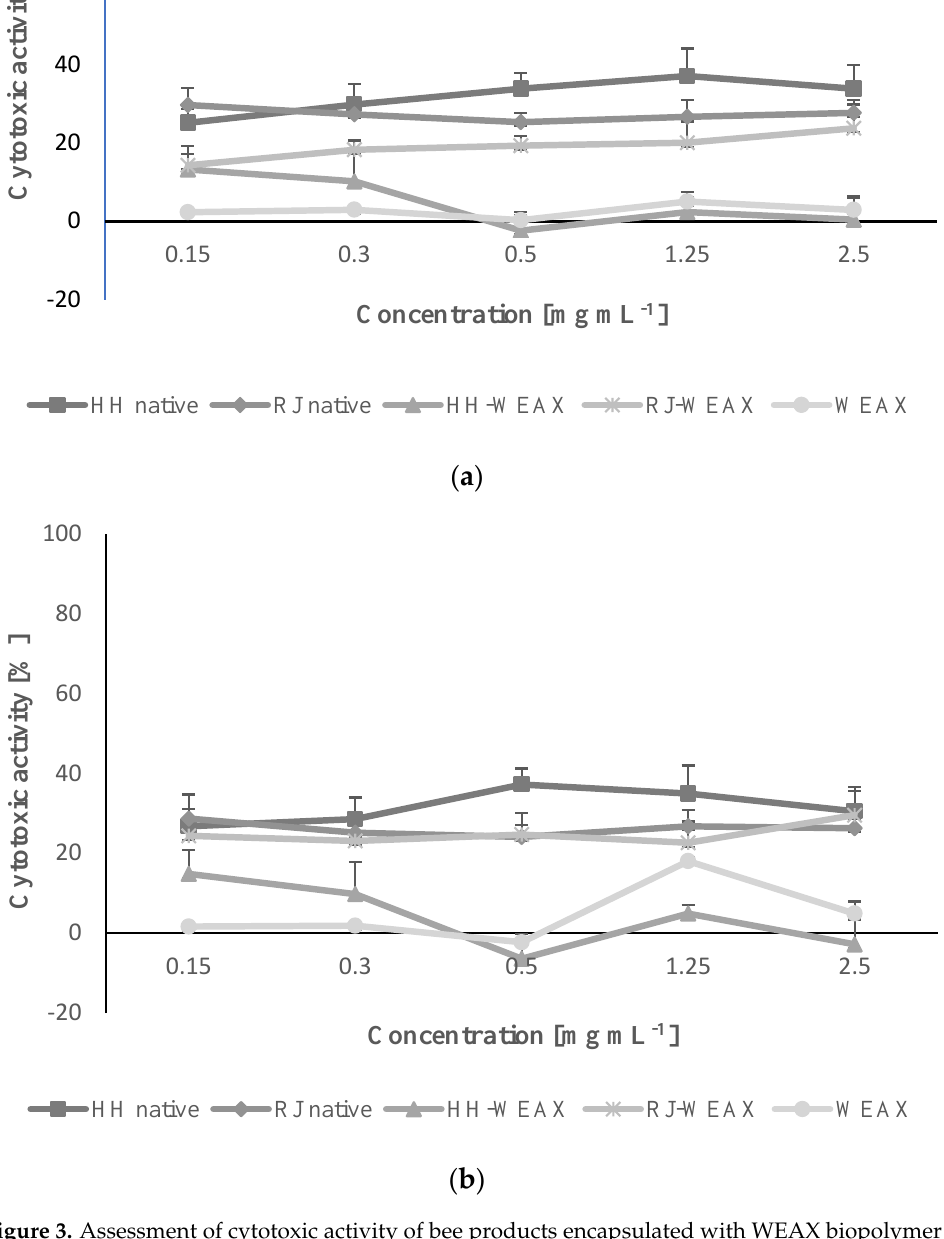
Figure 3. Assessment of cytotoxic activity of bee products encapsulated with WEAX biopolymer at 0.15 mg mL — 1 concentration against NIH-3T3 ( a ) and HMEC-1 ( b ) cells, determined with the MTT assay. Each value on the graphs represents the mean value ± SEM, n = 3 . The analysis of the results showed a comparable to the control sample (95%) rate of migration of HMEC-1 cells treated with native RJ (92%), HH-WEAX (87%) and RJ-WEAX (88%) in a time-dependent manner (Figure 4b). The microphotographs showing the changes in the cells migration of NIH-3T3 and HMEC-1 cells after 12 and 24 h incubation with microcapsules are presented in Figure 5a,b.